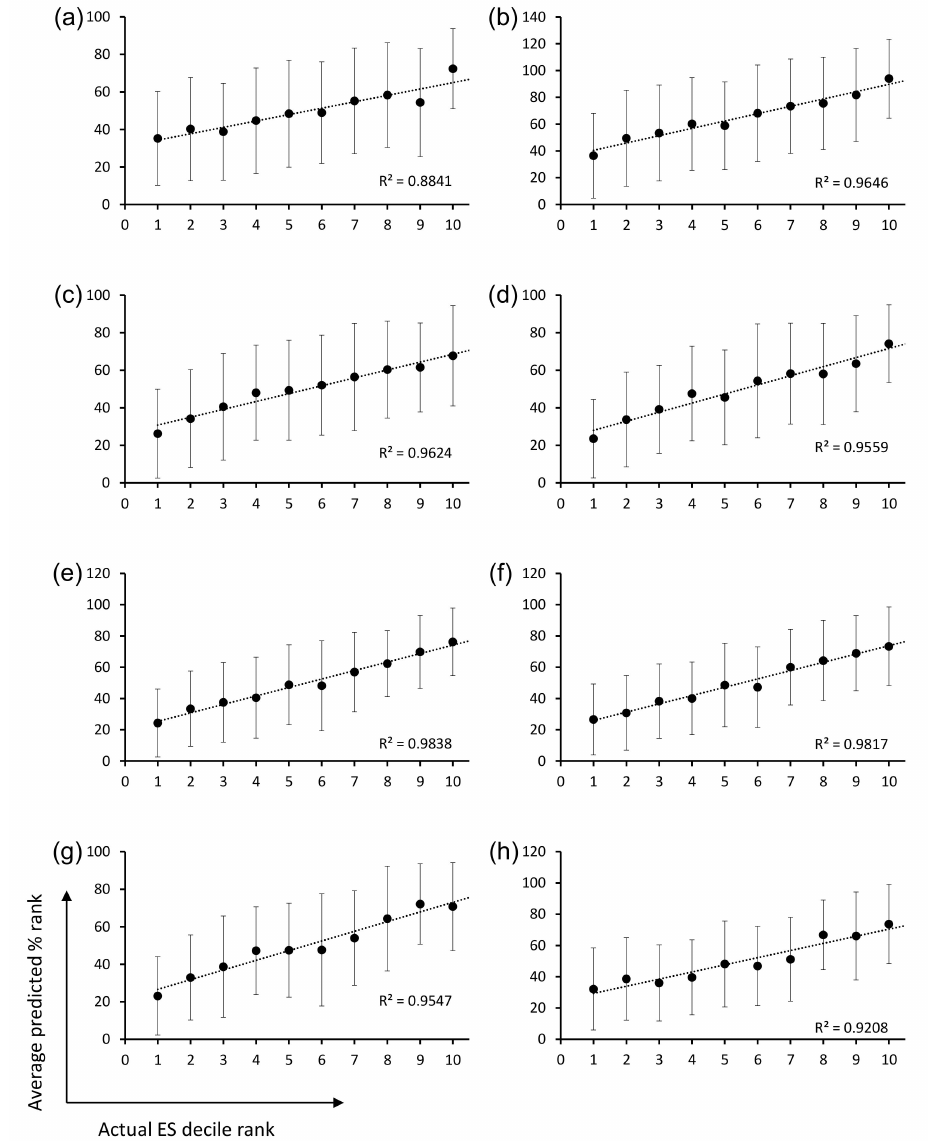
Figure 4. Plots of the average predicted enrichment score (ES) percentile rank of CDR-H3 sequences belonging to each decile rank of actual ES. The results for CDR-H3 sequences of length ( a ) 9 aa, ( b ) 10 aa, ( c ) 11 aa, ( d ) 12 aa, ( e ) 13 aa, ( f ) 14 aa, ( g ) 15 aa, and ( h ) 16 aa are shown. Error bars indicate standard deviations of the predicted